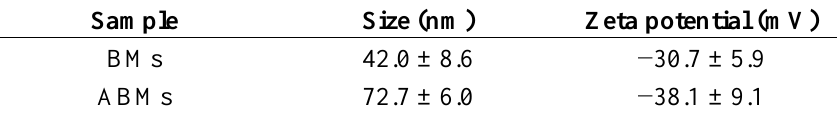
Table 1. Size and zeta potential of BMs and ABMs.